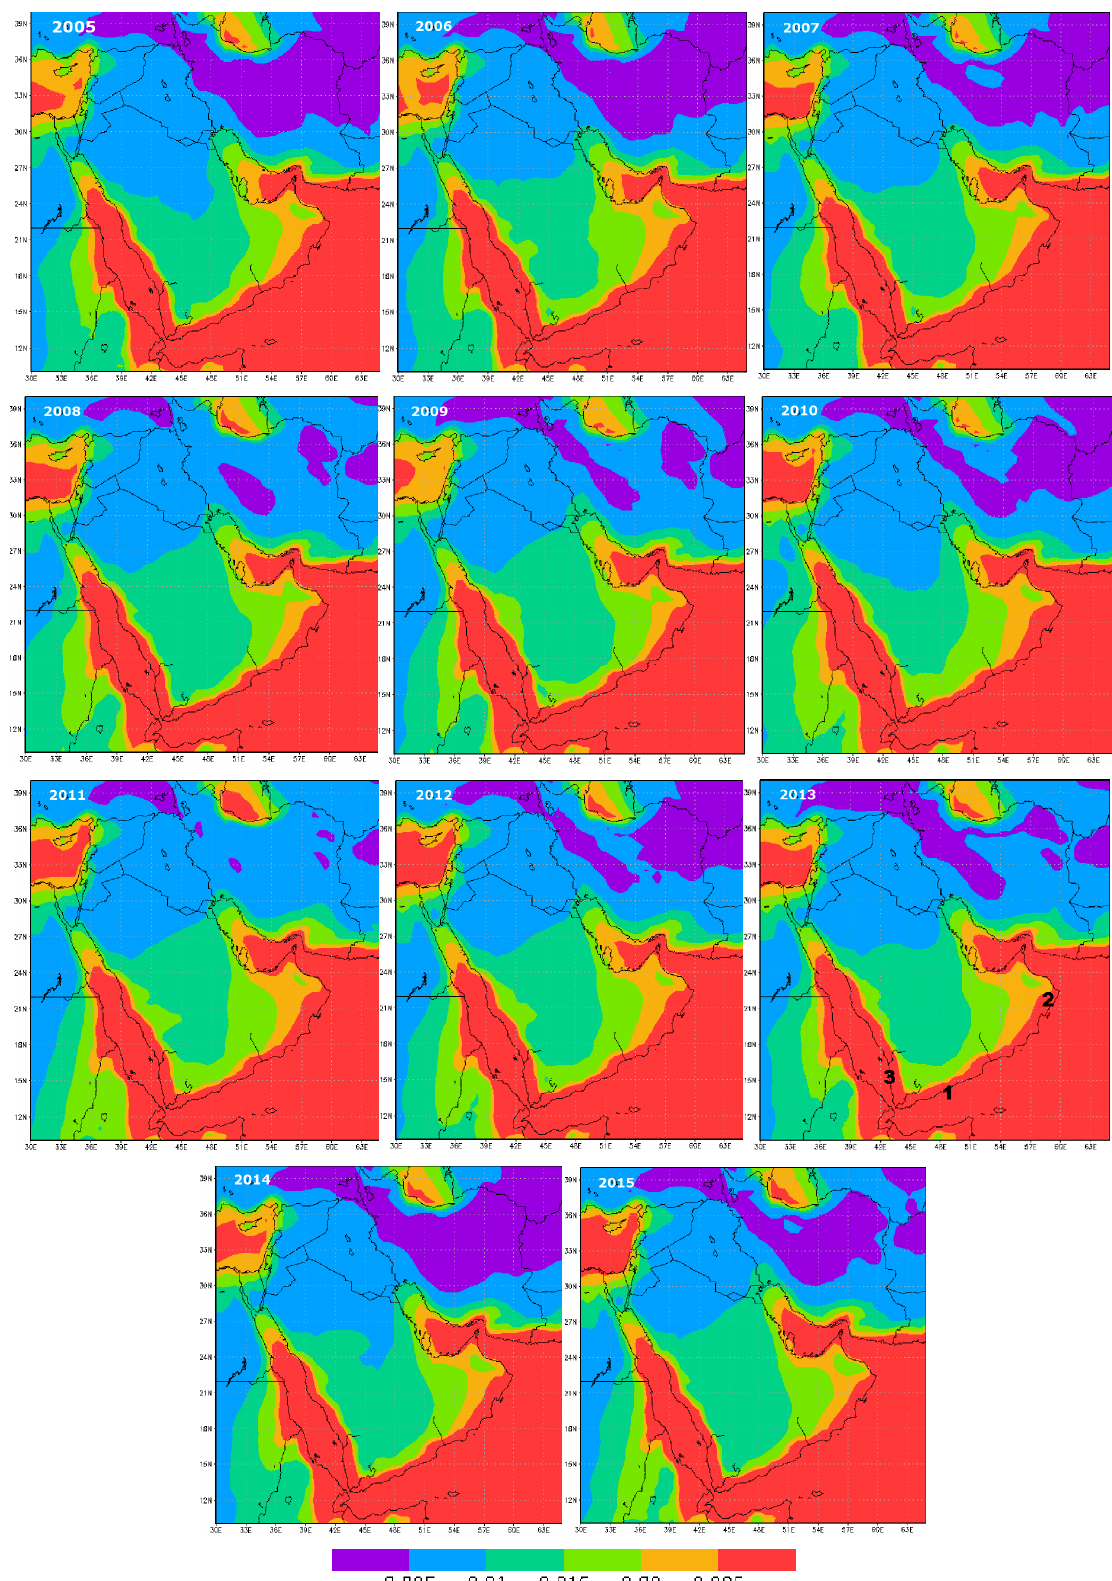
Figure 4. Inter-annual variation of sea salt AOT over the Arabian Peninsula from 2005 through 2015. Also shown in the 2013 panel: (1) The region of southern Yemen with the Hadramawt mountain range, (2) the Al Hajjar mountainous region of Oman that is also the wettest part of the Arabian Peninsula, and (3) the Asir mountains in the western and south western Arabian Peninsula.